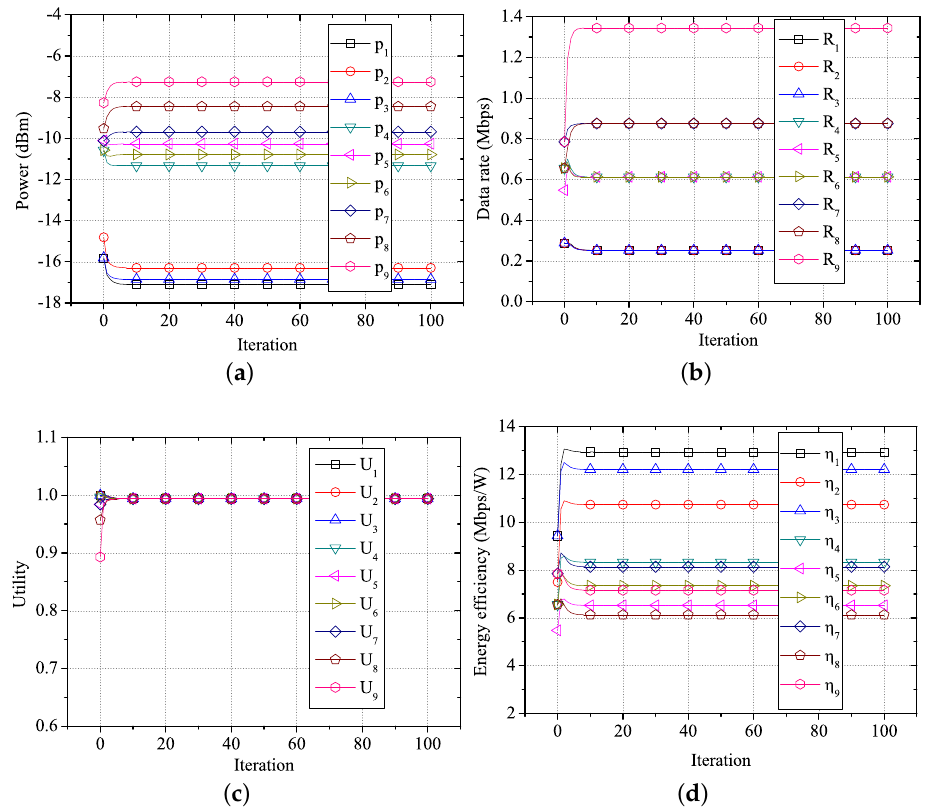
Figure 9. Performance of FTPC-U over time. ( a ) Transmission power over time; ( b ) data rate over time; ( c ) utility over time; ( d ) energy efficiency over time.